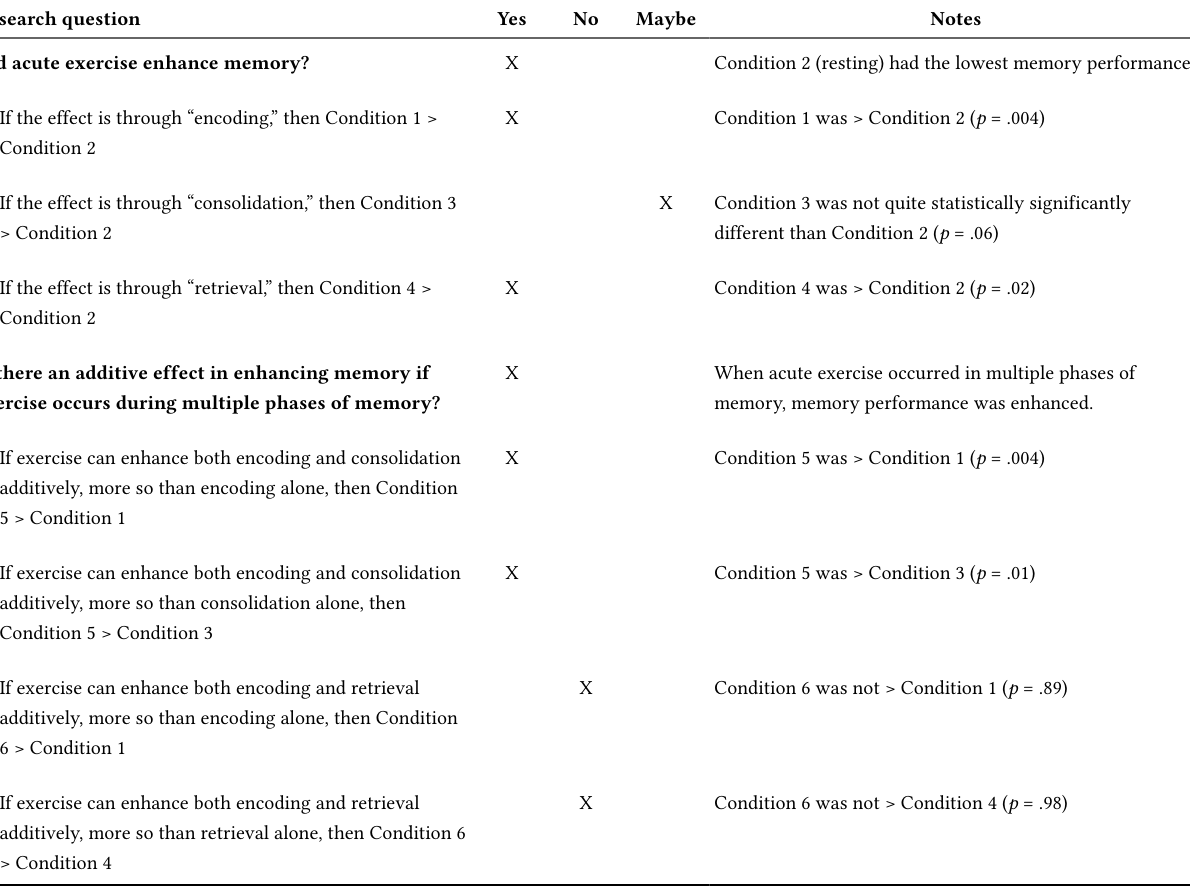
Table 8 indicates the results for each specific research question. Table 8 Summary of Results for Experiment